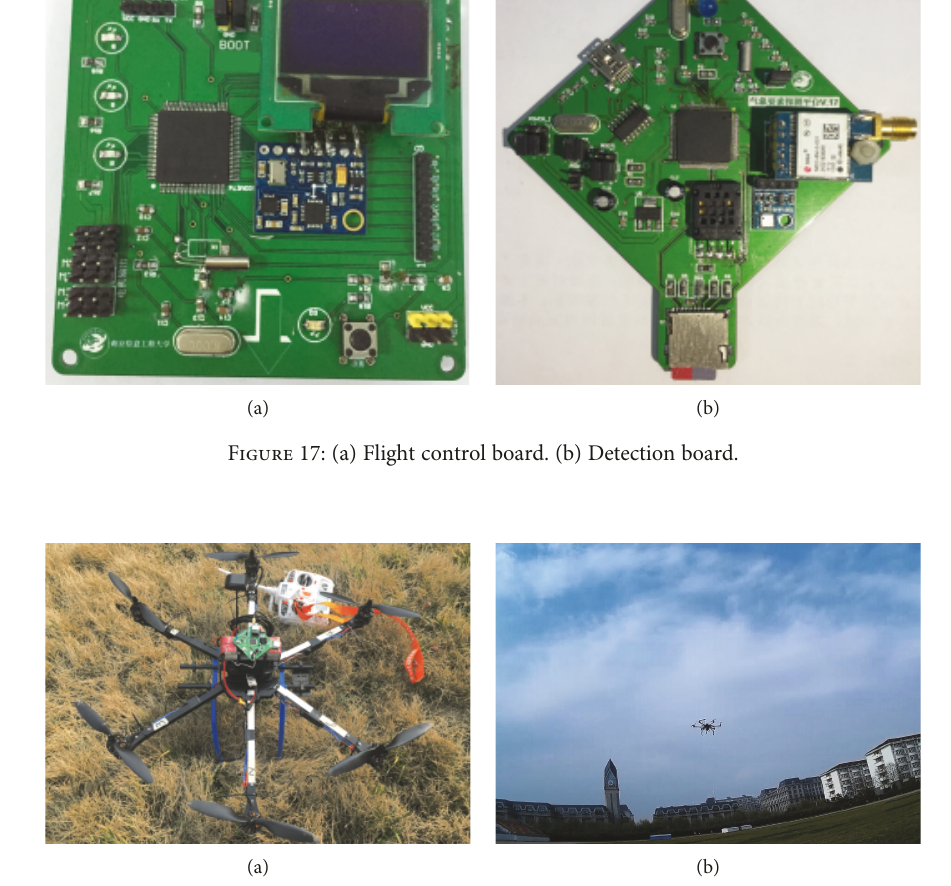
Figure 18: (a) Model six-rotor UAV. (b) Test fl ight